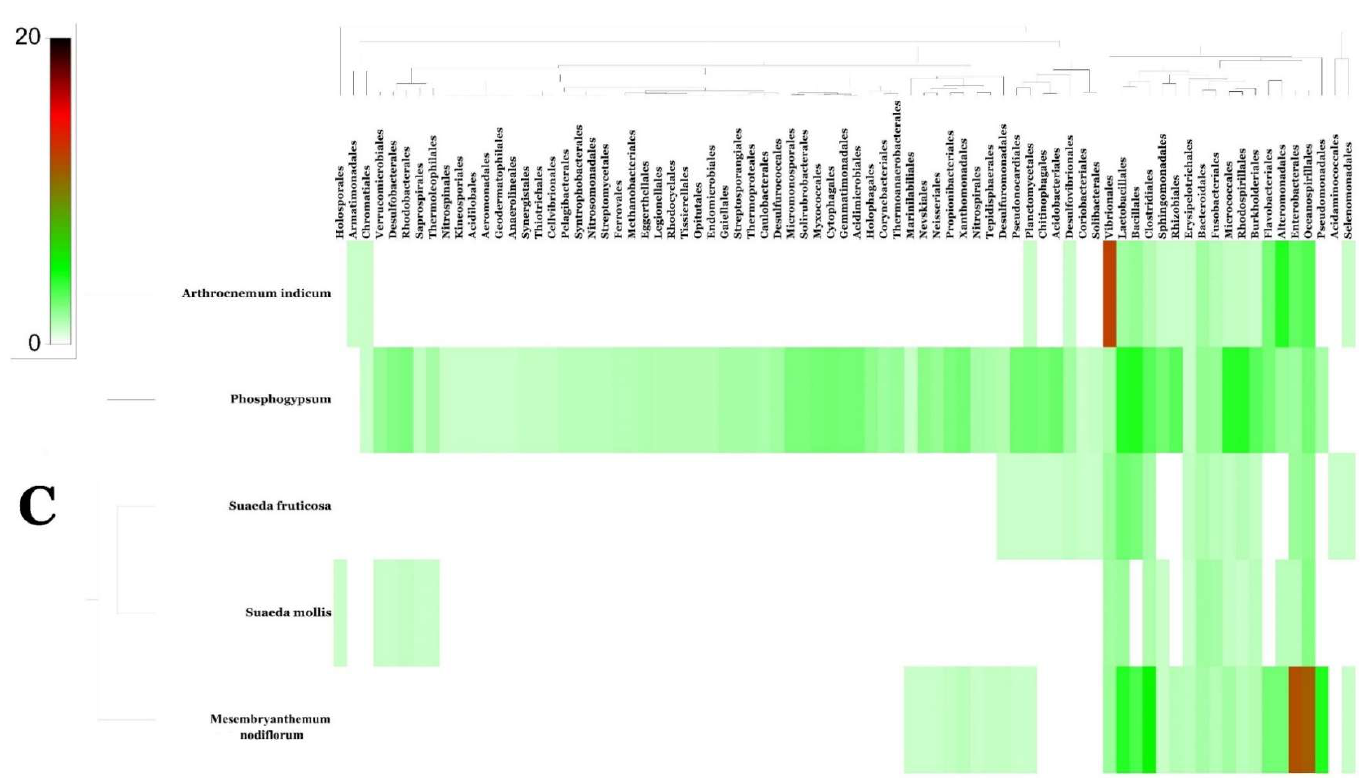
Figure 4. Bacterial community heat map of PG and plant microbiomes generated using SEED2 in phylum ( A ) order ( B ) and class ( C ) levels, respectively.